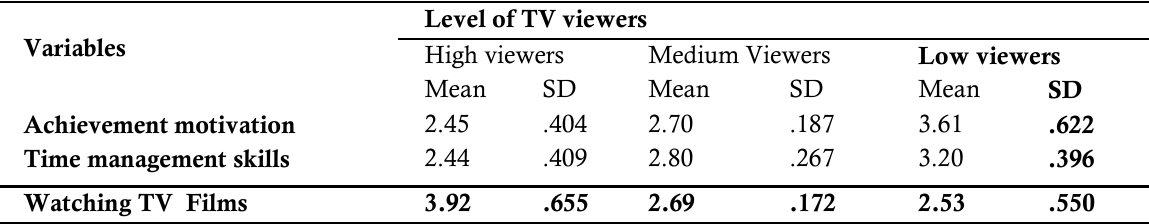
Table 1. Means and Standard Deviations of the Variables Treated in the Study Level of TV viewers Variables High viewers Achievement motivation